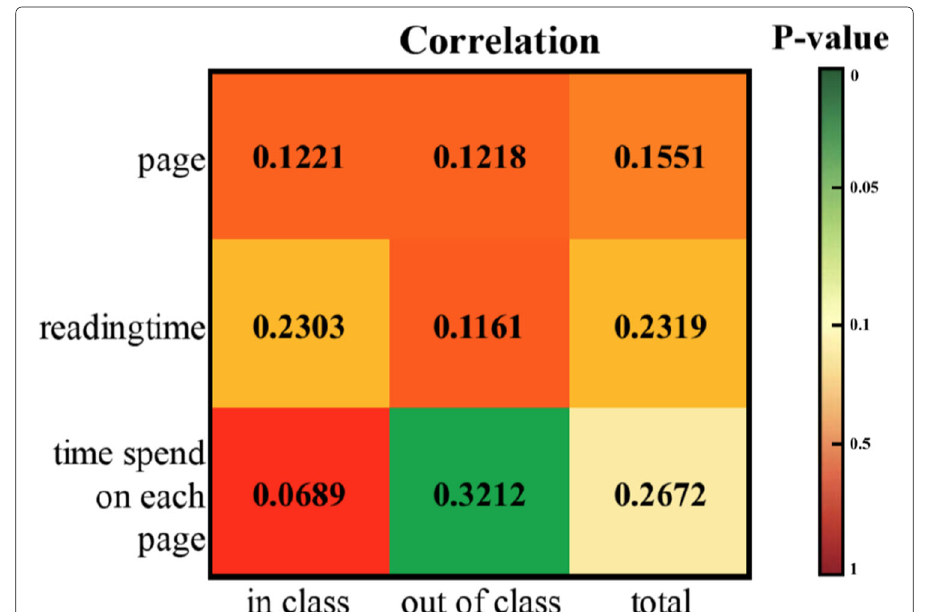
Fig. 6 Indicators and correlation with the final exam score